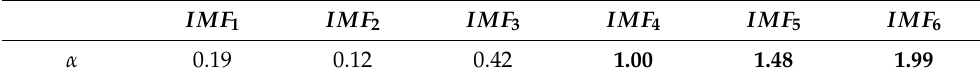
Table 3. The scaling exponent α of each IMF.